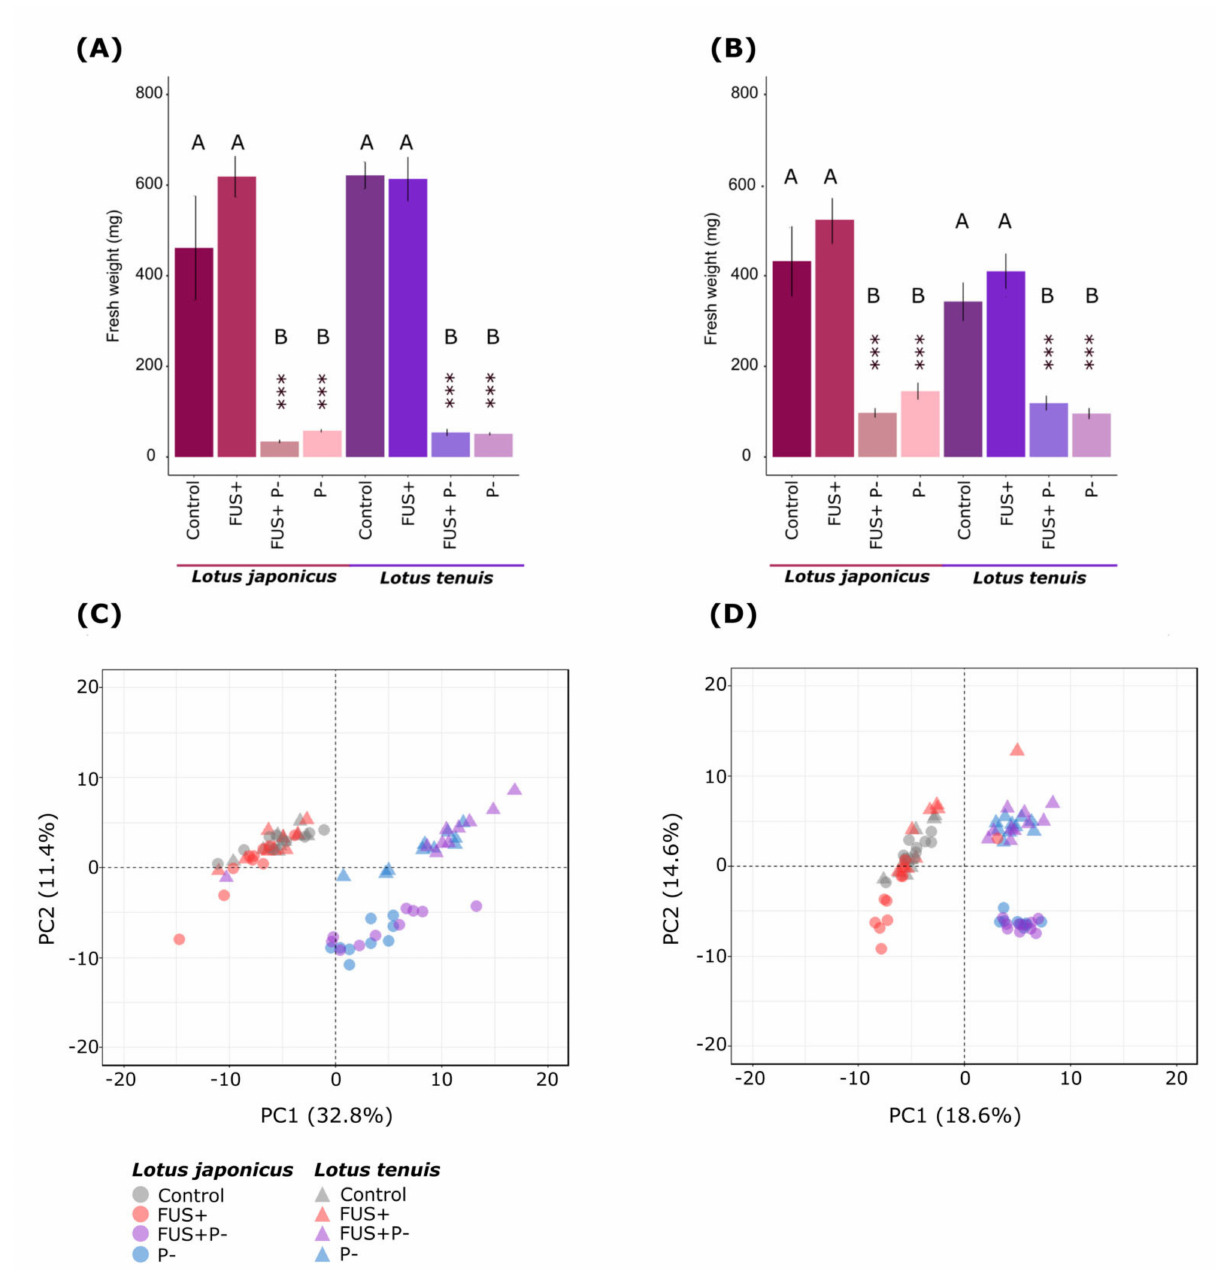
Figure 1. Modification of biomass of the shoots ( A ) and roots ( B ) of L. japonicus and L. tenuis after 32 days of inoculation with F. solani 142L52B and Pi starvation treatment. Statistical differences between the control condition (noninoculated—optimal Pi) and each treatment were assessed using Student ´ s test (mean ± standard deviation), *** p < 0.001. The different letters indicate statistically significant differences according to Tukey’s test ( p < 0.05). Principal component analysis (PCA) based on the metabolite profiles of shoots ( C ) and roots ( D ) of L. japonicus and L. tenuis after 32 days of inoculation with F. solani 142L52B and Pi starvation treatment: Control (Non-Inoculated-Optimal Pi), FUS+ (inoculated—Optimal Pi), P- (non-inoculated—Pi starvation), FUS+P- (inoculated—Pi starvation). The relative concentration of metabolites references the Control condition and is log 2